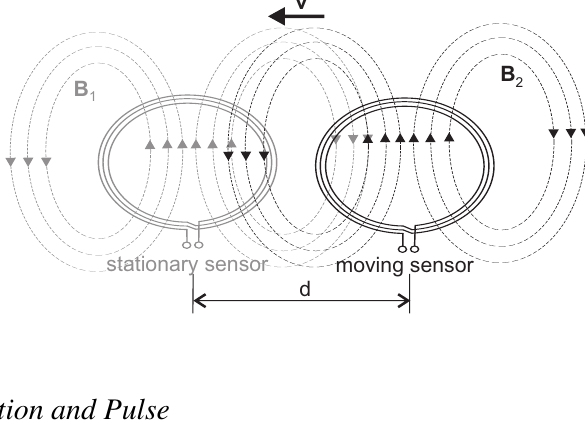
Figure 5. Measurement setup for the investigation of the mutual interaction between adjacent coils.